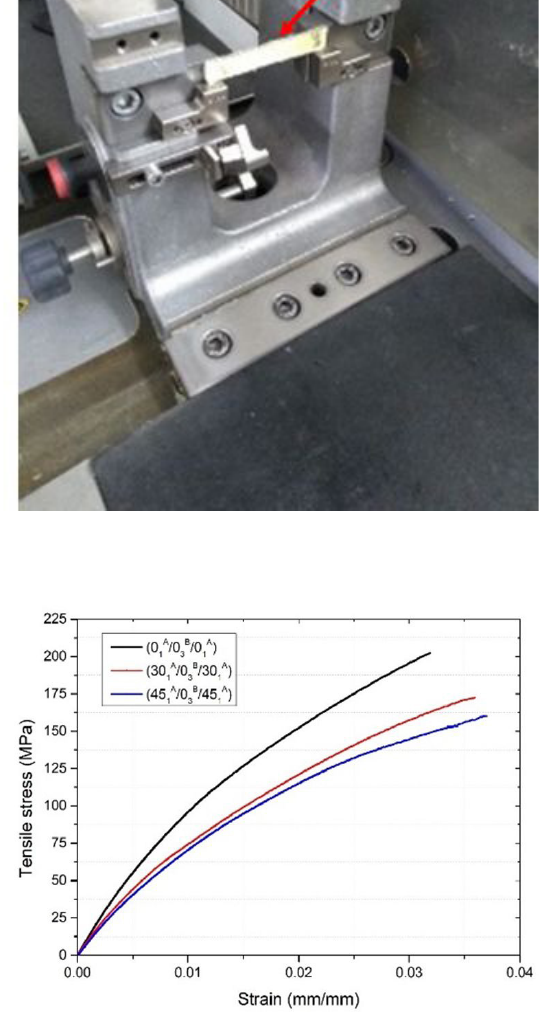
Figure 6. Stress-strain curves corresponding to maximum tensile strength